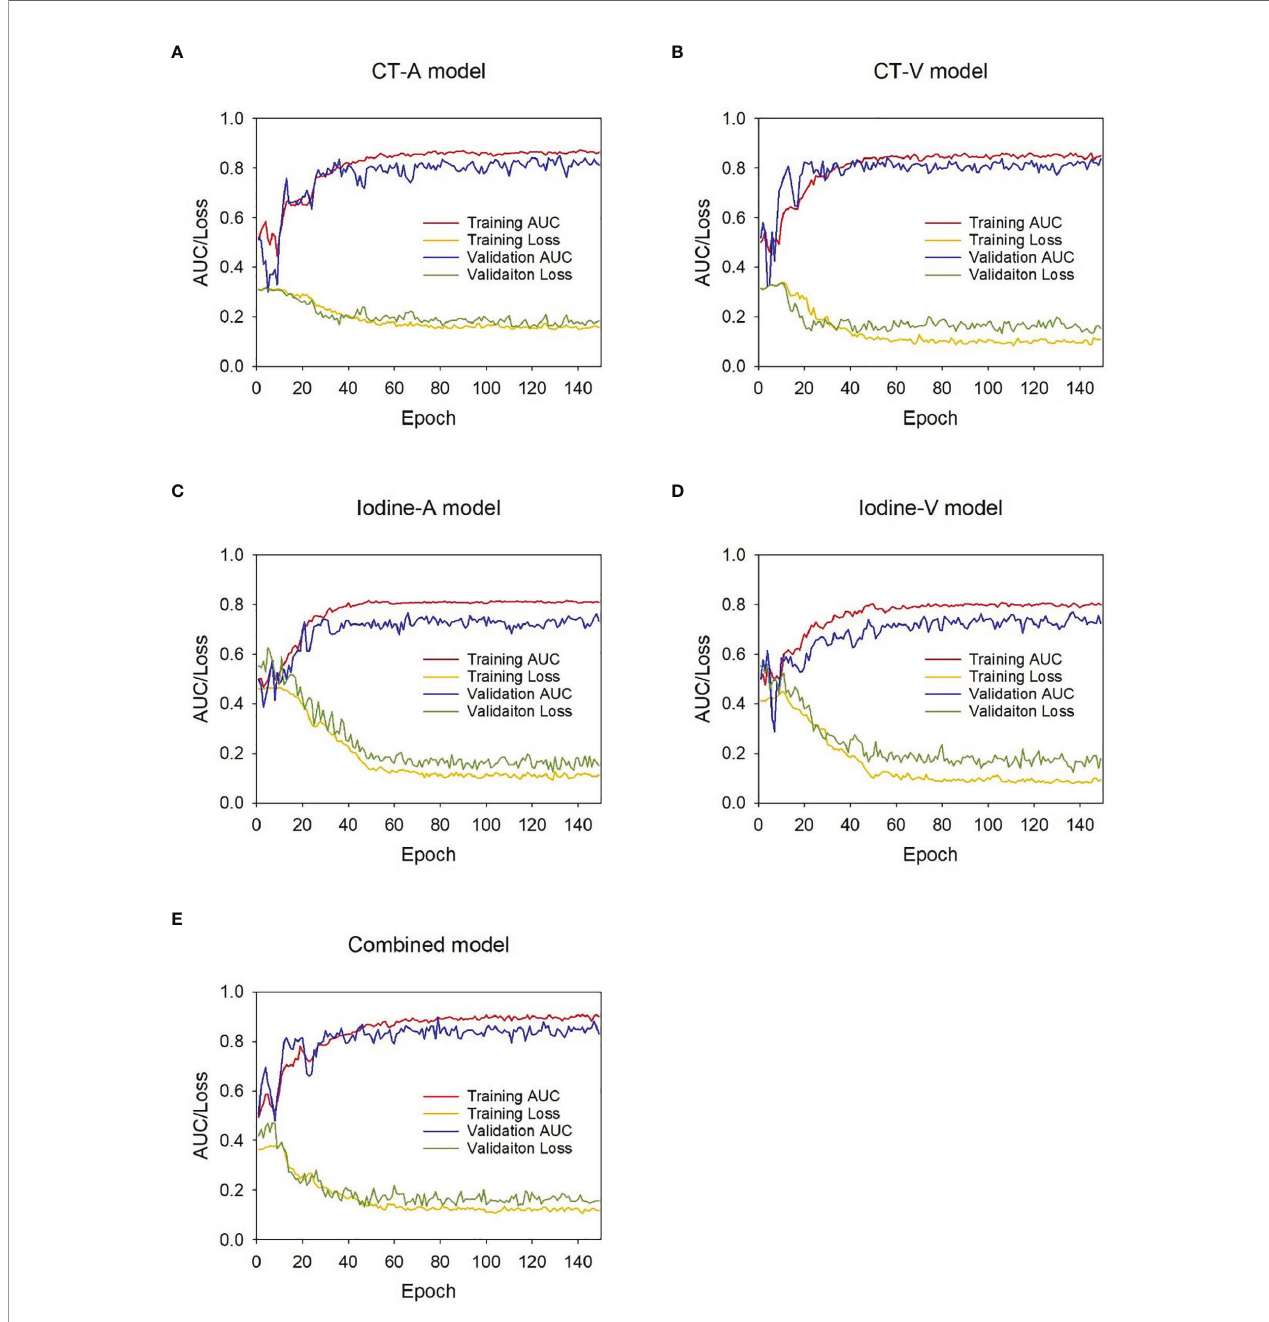
FIGURE 3 | AUC-loss curve of the DL models during development stage. (A) CT-A model, (B) CT-V model, (C) Iodine-A model, (D) Iodine-V model , (E) Combined